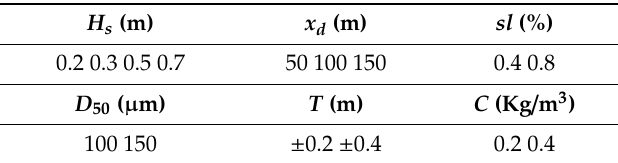
Table 1. Variables for run combinations.